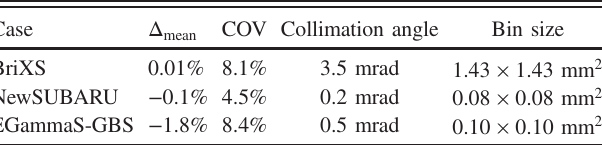
TABLE IV. Analysis of binwise difference between the spatial distributions at 10 m from the IP of the collimated photon beams simulated with CAIN and GEANT 4 . The mean ( Δ coefficient of variation (COV) of the residuals are reported.